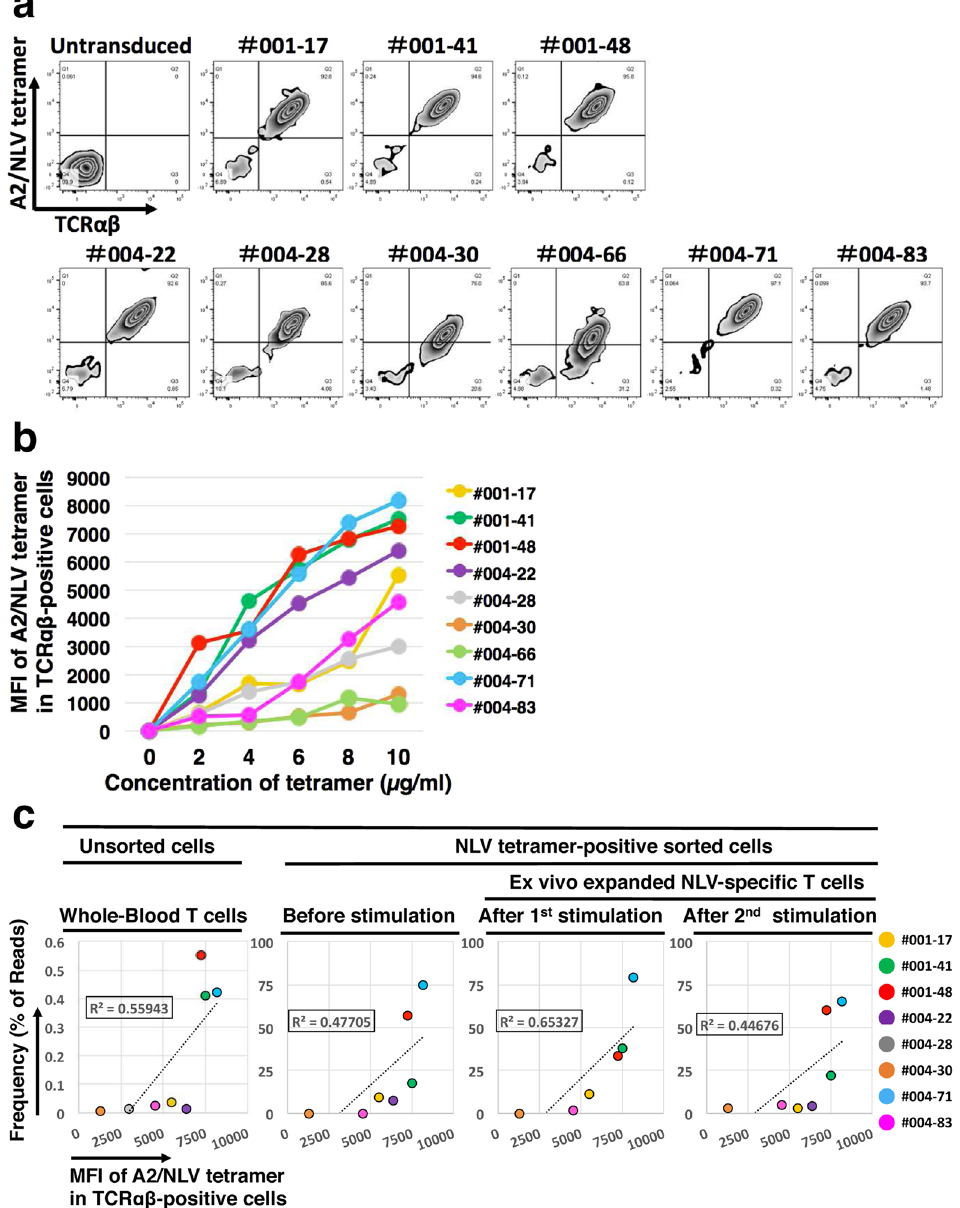
Figure 3. Binding affinities of the dominant and subdominant CMV NLV-specific TCRs. ( a ) Flow cytometry was used to measure the levels of TCR expression by TCR-transductants and to determine the binding affinities of TCRs for the NLV peptide/MHC complex. Sequences representing the TCRs identified using single-cell multiplex clonotypic analysis were used to transfect Jurkat cells that lack TCR αβ expression that were probed using the HLA-A2-NLV tetramer-PE and anti-TCR αβ -APC. ( b ) Binding analysis of the dominant and subdominant CMV NLV-specific TCRs. Jurkat cells that lack TCR αβ expression transduced with CMV NLV- specific TCRs were reacted with HLA-A2-NLV tetramer-PE at the indicated concentrations. Mean fluorescence intensity (MFI) of the cells is plotted vs HLA-A2-NLV-tetramer concentration. ( c ) The relationship between the MFIs of Jurkat cells that lack TCR αβ expression transduced with CMV NLV-specific TCRs and the frequencies of clonotypes were estimated according to the percentage of the NGS reads of the TCR sequences. MFI values of Jurkat cells that lack TCR αβ expression transduced with CMV NLV-specific TCRs are plotted vs the estimated frequency of the T-cell clonotypes (left panel) of sorted cells from unstimulated (second left panel), one (second right panel) and two rounds (right panel) of stimulated T cells. Correlation was assessed using Spearman’s rank correlation coefficient. All samples in this analysis were derived from CMV-seropositive and HLA-A2-positive donors, V001 and V004, respectively. The frequencies of the CMV NLV-specific T-cell clones in samples were estimated from the number of unique reads that correlated positively with the binding affinities of the TCRs. The correlation coefficients are shown in each plot. The correlation was consistently independent of the number of antigen